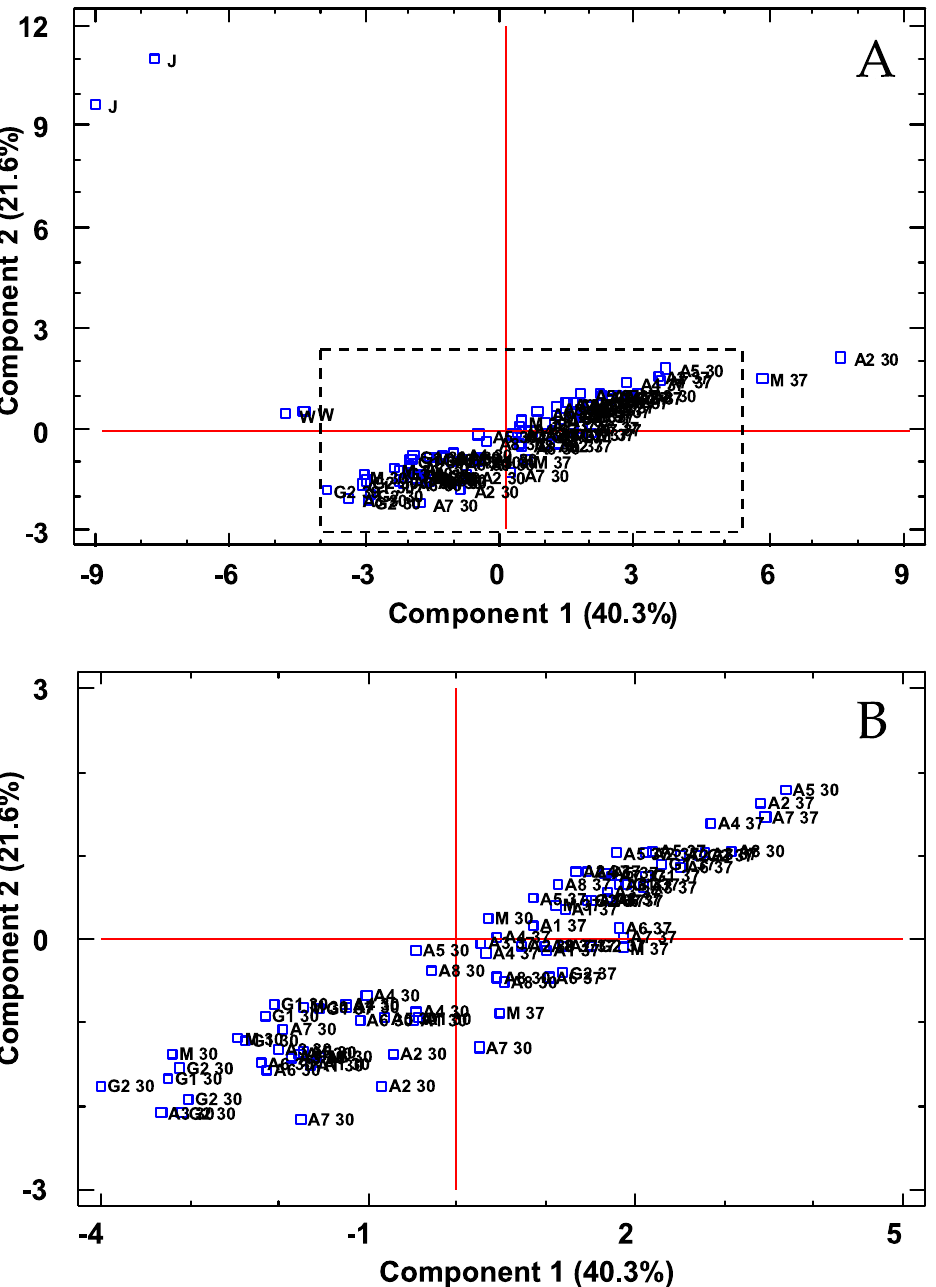
Figure 4. PCA on phenolic compounds. Distribution of all the samples onto the plane defined by the first two PCs. ( A ): original graph; ( B ): zoomed area. J: prickly pear juice; W: prickly pear wine; A/G/M: prickly pear vinegar.